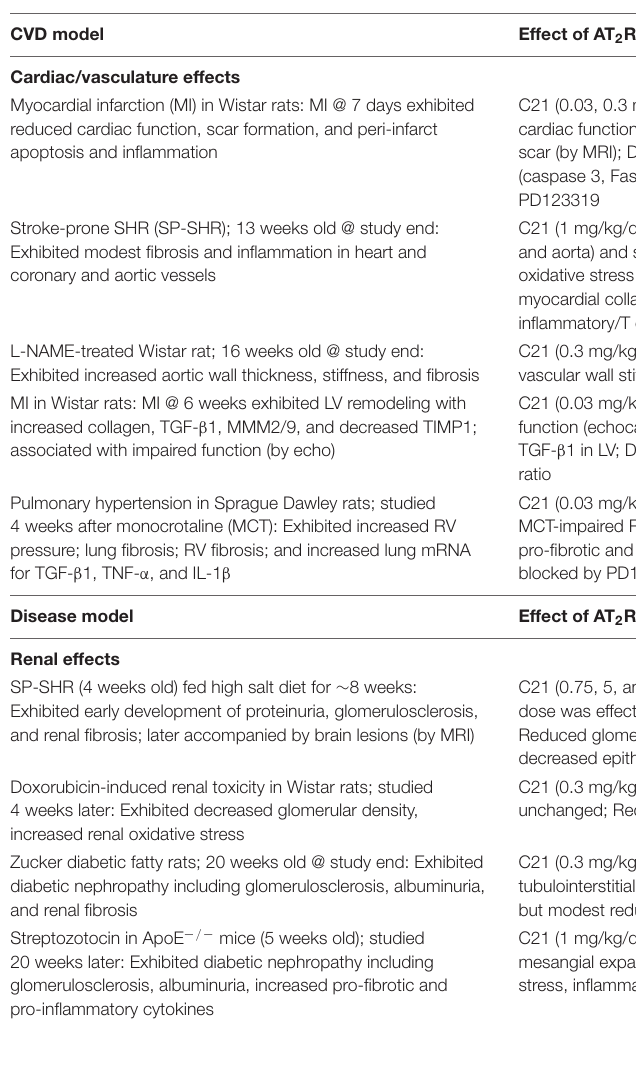
TABLE 1 | Summary of anti-fibrotic and related protective effects evoked by chronic treatment with